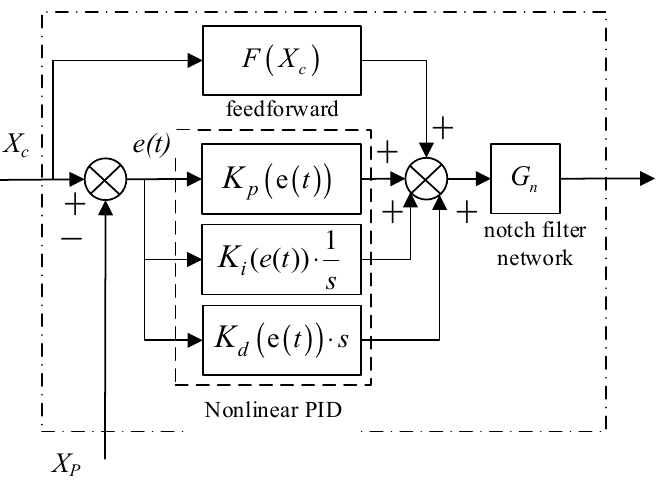
Figure 12. The combined control strategy. The control algorithm comprises three parts: a notch filter network, a nonlinear PID and a feedforward